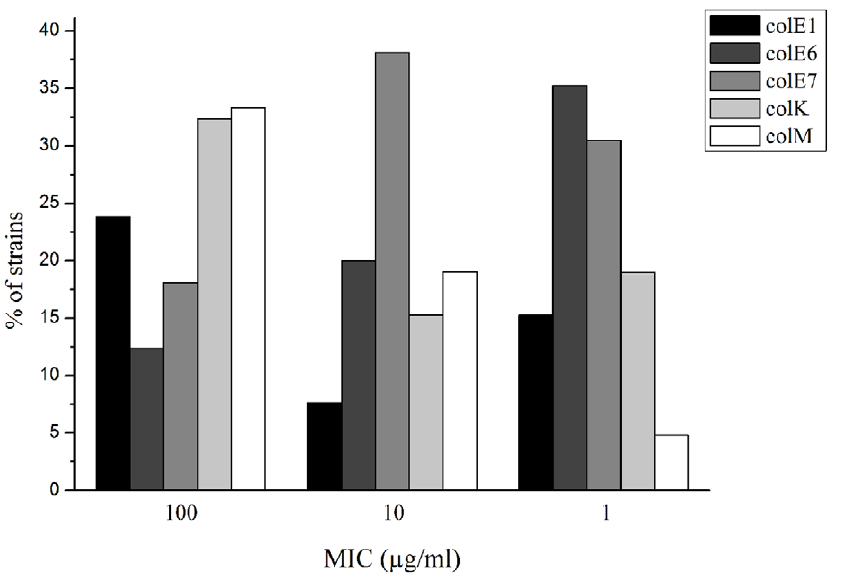
Figure 1. Percentages of uroseptic E.coli strains with minimal inhibitory concentrations (MIC) for colicins E1, E6, E7, K and M.